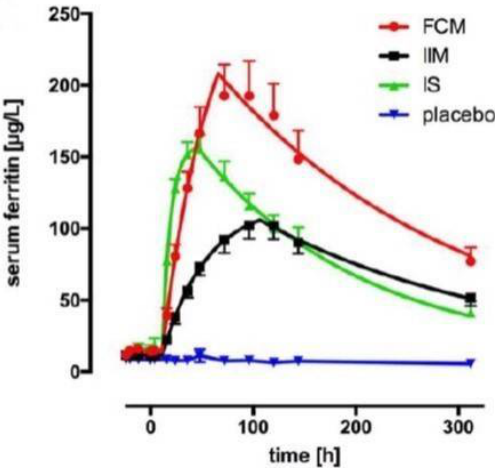
Figure 4. Cumulative serum ferritin profiles for treatment groups, fitted using global fitting with a custom function (plateau followed by mono-exponential association followed by mono-exponential decay), FCM = ferric carboxymaltose, IIM = iron isomaltoside, IS = iron sucrose [43].